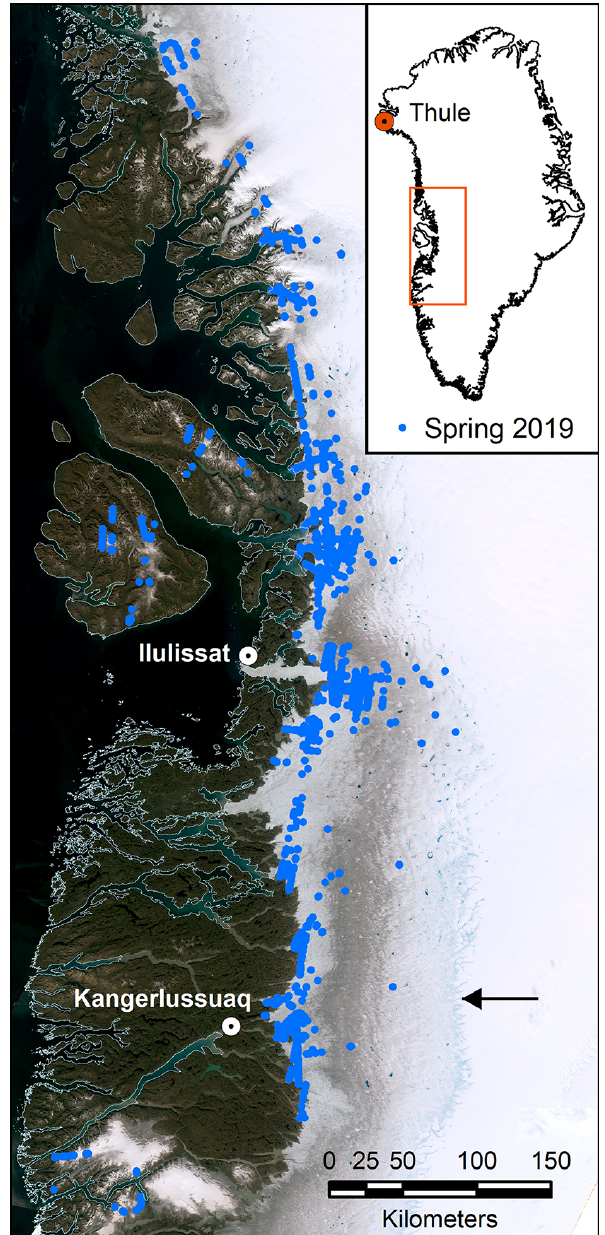
Figure 6. Locations of hydrological features in central west Green- land identified in spring 2019 data (blue circles). Background image is a Sentinel-2 image mosaic from MacGregor et al. (2020) from August 2019. The approximate location of the transition between the ablation zone and the accumulation zone (equilibrium line) in August 2019 is indicated by the black